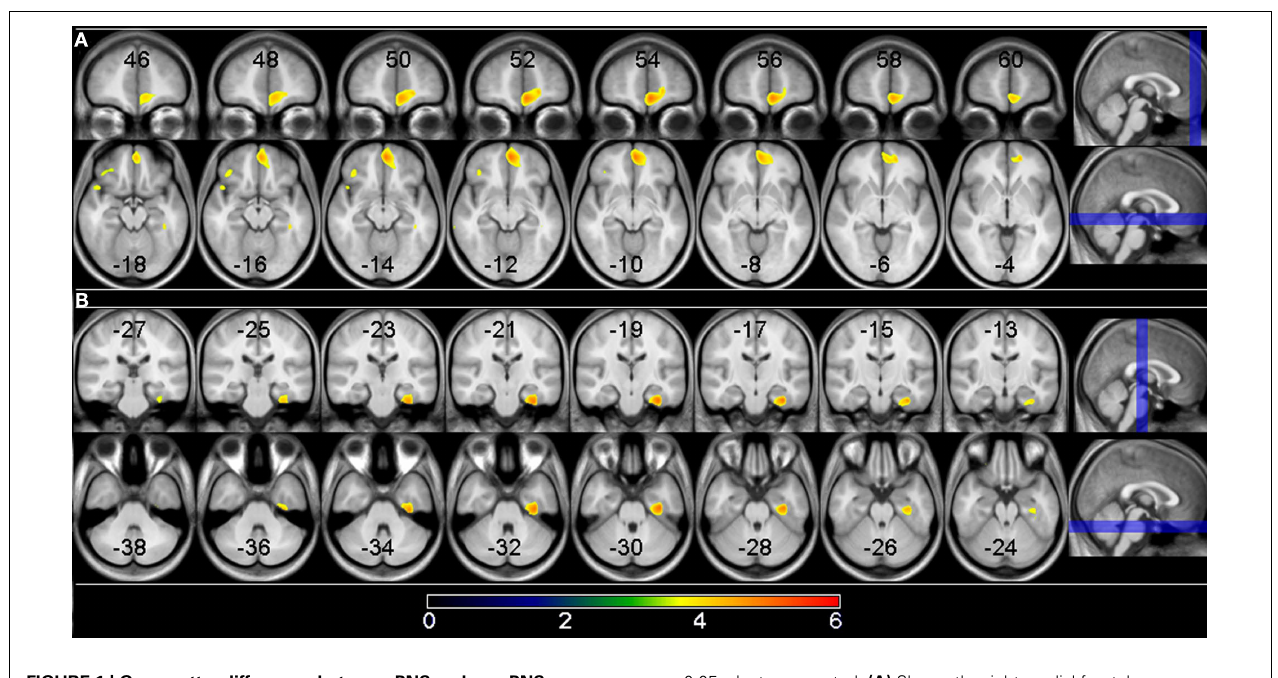
FIGURE 1 | Gray matter differences between PNS and non-PNS patients. Voxels where significant group differences were observed are depicted in color and are superimposed on aT1 MRI template image.The highlighted areas indicate smaller gray matter volume in PNS patients compared to non-PNS patients at a significance level of